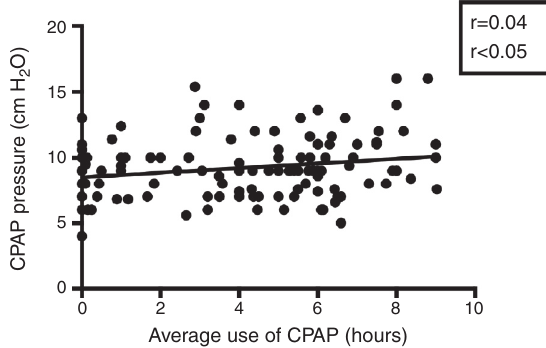
Figure 1 Correlation between the average hours of use of CPAP and CPAP pressure used in the patients analyzed. Study with Pearson’s linear regression.